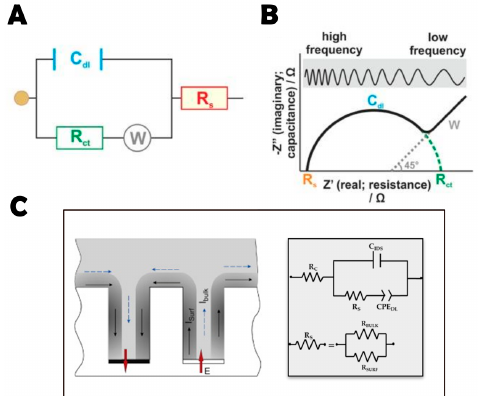
Figure 4. Data from EIS represented by ( A ) the Randles circuit; and ( B ) the Nyquist plot showing the features of the Randles circuit. It illustrates the components of the system: double-layer capacitance (C dl ), charge transfer resistance (R ct ), solution resistance (R s ), and Warburg impedance (W). It should be noted that the Nyquist plot R ct represents the semicircle diameter, so the right end of the semicircle indicates R ct +R s and not R ct . Reprinted from [4], with permission from American Society for Microbiology. Copyright © 2014. ( C ) The electrical equivalent circuit used for impedance spectra fitting in IDEA surfaces in low conductivity KCl solutions in the absence of faradaic processes. Reprinted from [104], with permission from Elsevier. © 2016 Elsevier